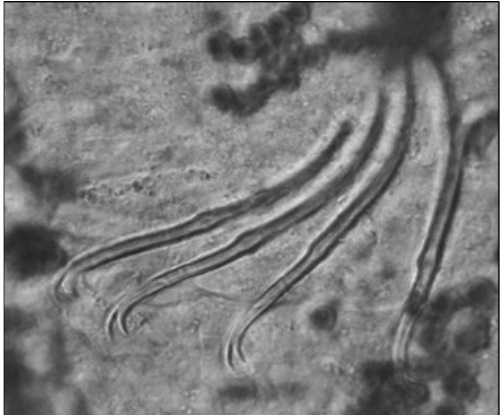
Figure 8. Multiple bifid ventral